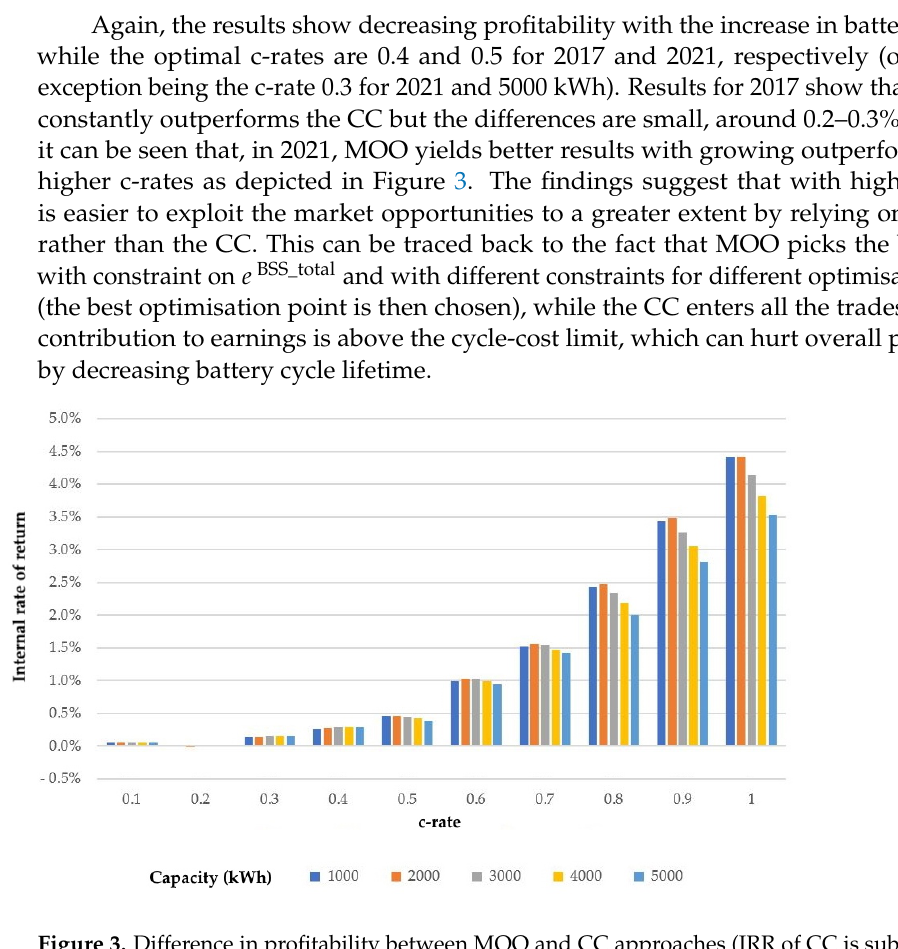
Figure 3. Difference in profitability between MOO and CC approaches (IRR of CC is subtracted from IRR of MOO) in 2021 and battery capacity price of 100 € /kWh.